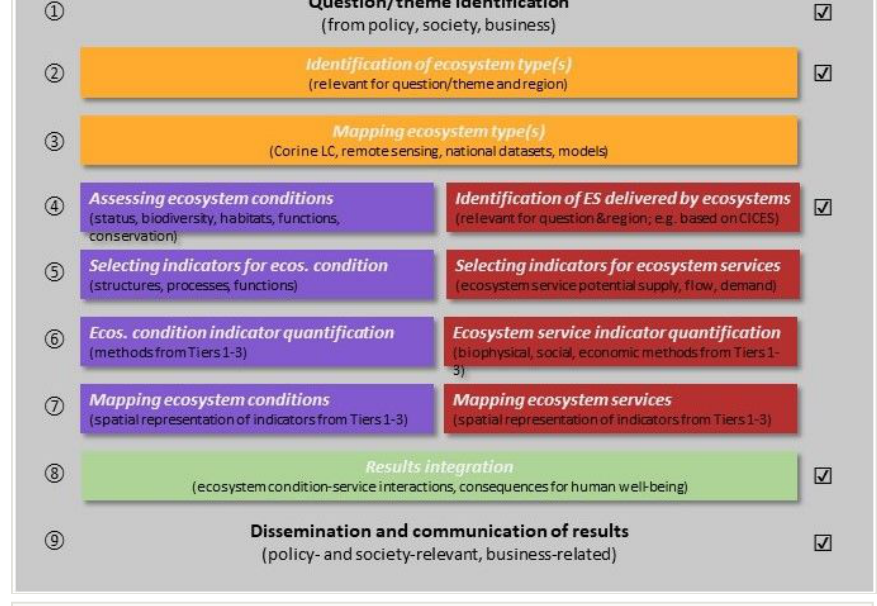
Figure 2. Matching the MAES assessment framework (a; Maes et al. 2014) and the ESMERALDA integrated ecosystem assessment framework (b; Burkhard et al. 2018) to our cascade-based conceptual framework (c; Fig. 1) and to our work fl ow (d; Fig.